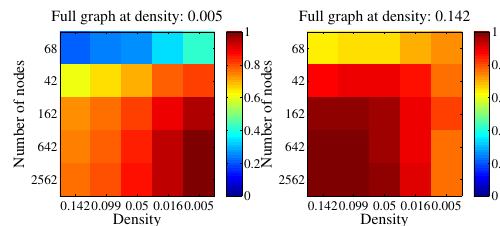
Fig. 14. Similarity of evolutions for varying grid size and density of the graphs compared to the original graph with 2562 nodes. Left panels: original graph density 0.005. Right panels: original graph density 0.142.